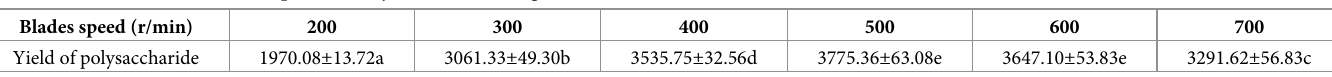
Table 4. Effect of different blades speed on the yield of MRYP (mg/L).